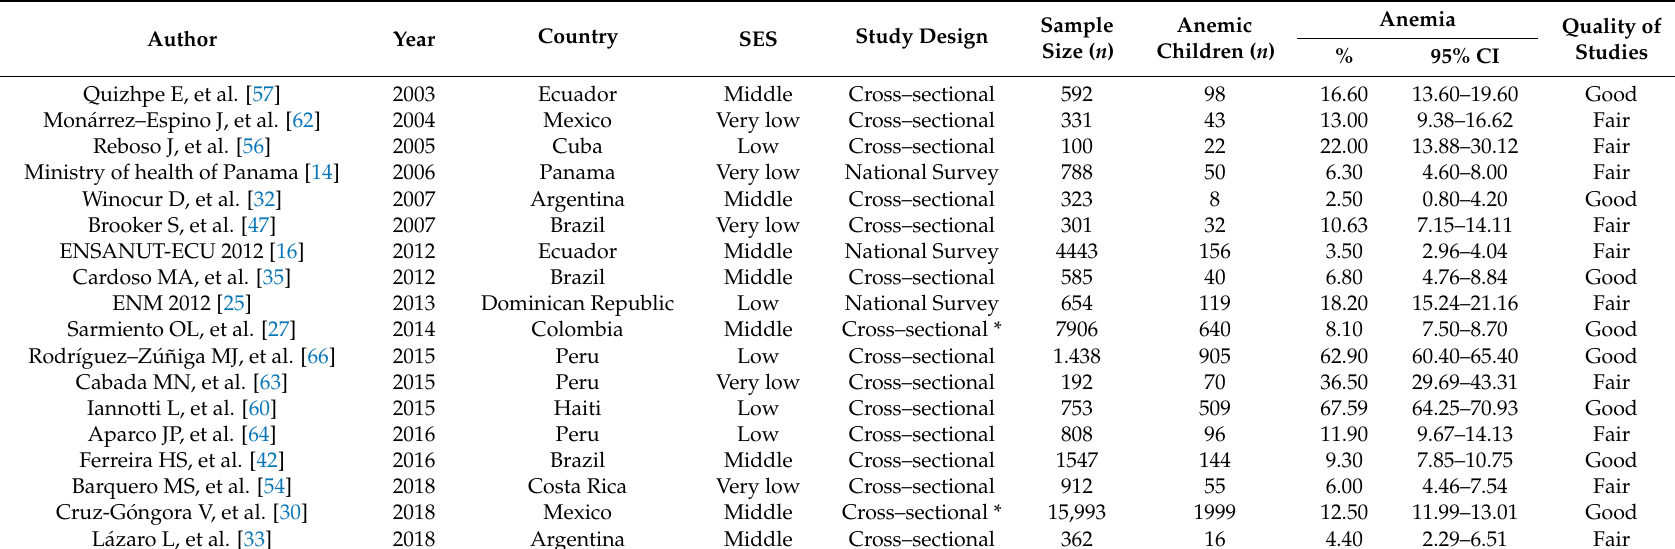
Table 2. Characteristics of studies that assessed schoolchildren (5-12